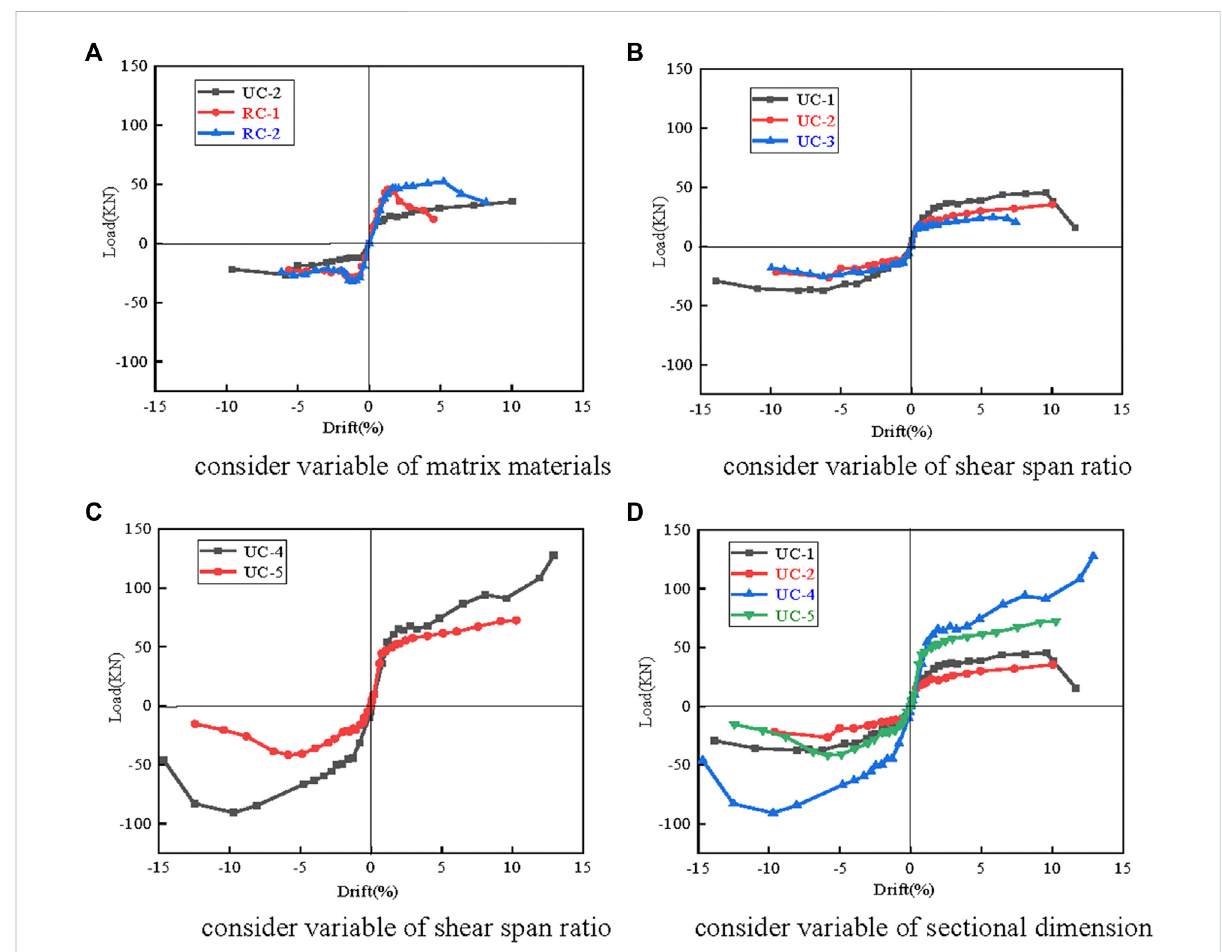
FIGURE 6 Skeletoncurves.Driftvs.loadforceskeleton. (A) DifferenceinducedbyintroducingECC. (B) In fl uenceofshearspanratio. (C) In fl uenceofshear span ratio. (D) In fl uence of sectional dimension.